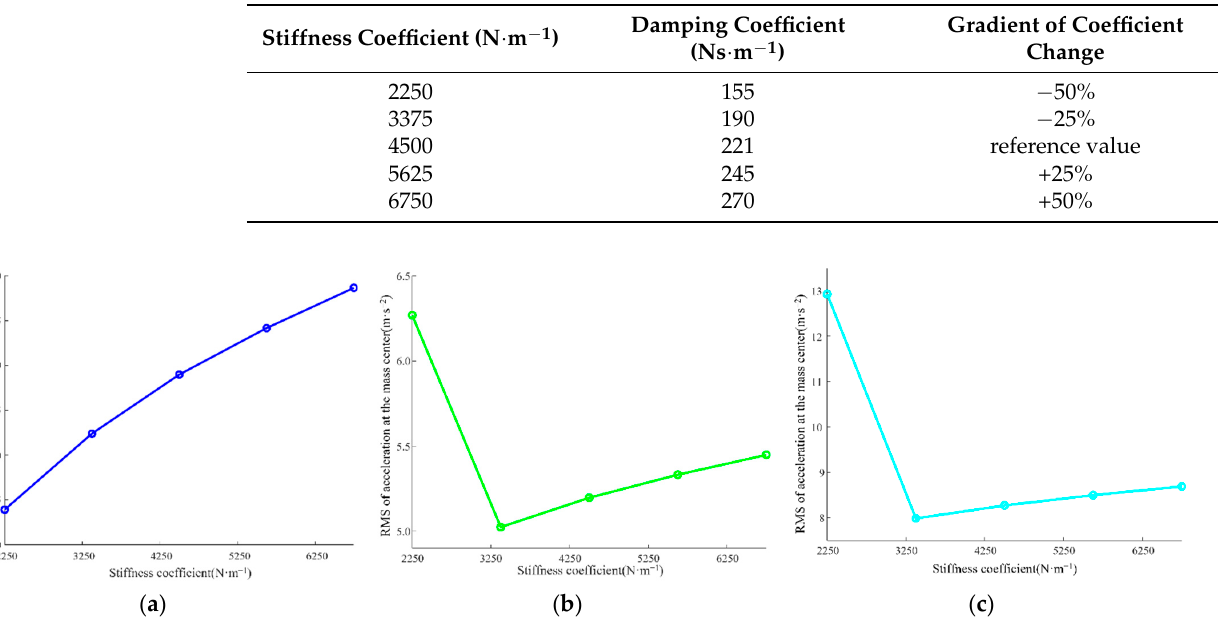
Figure 13. Stiffness change simulation comparison for large heave motion. ( a ) The amplitude of 0.1 m; ( b ) the amplitude of 0.25 m; ( c ) the amplitude of 0.4 m.